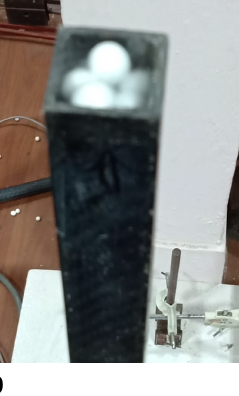
EPS foam balls of 9 mm and 18 mm diameter are used to fill the tube as shown in Figures 2a and 2b, respectively.